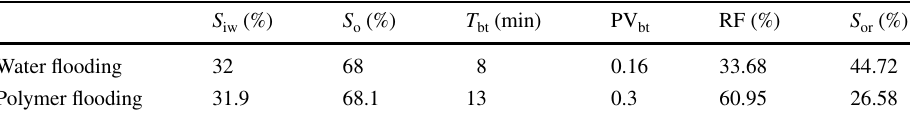
Table 7 The summarizations of the core flooding